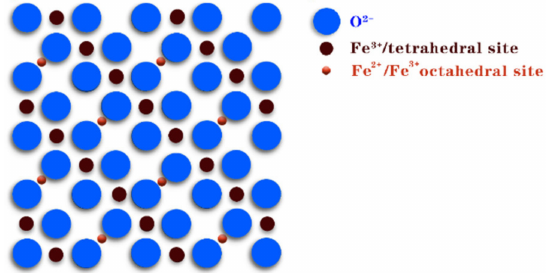
Figure 7. Crystal structure of Fe 3 O 4 .